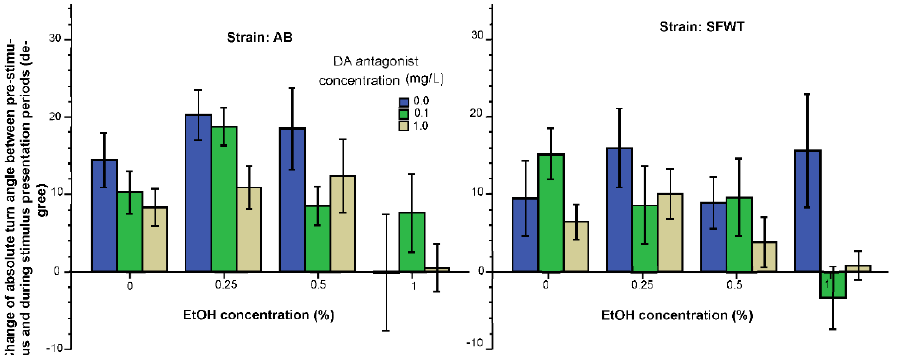
Figure 6. Change of absolute turn angle elicited by the presentation of animated conspecific images is influenced by the concentration of acute alcohol (X-axis) and by the concentration of acute D1-R antagonist (legend) in an additive manner. Mean ± S.E.M. are shown.